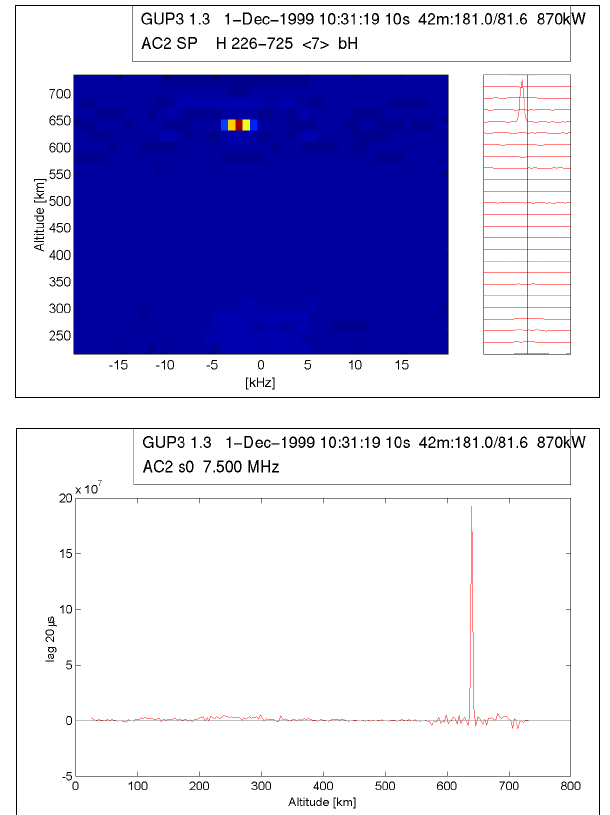
Fig. 4. Results showing (a) spectra, and (b) power profile for AC2 data at 10:31:19UT, 1 December 1999, using EISCAT rtg3 program when a probable satellite was seen in the